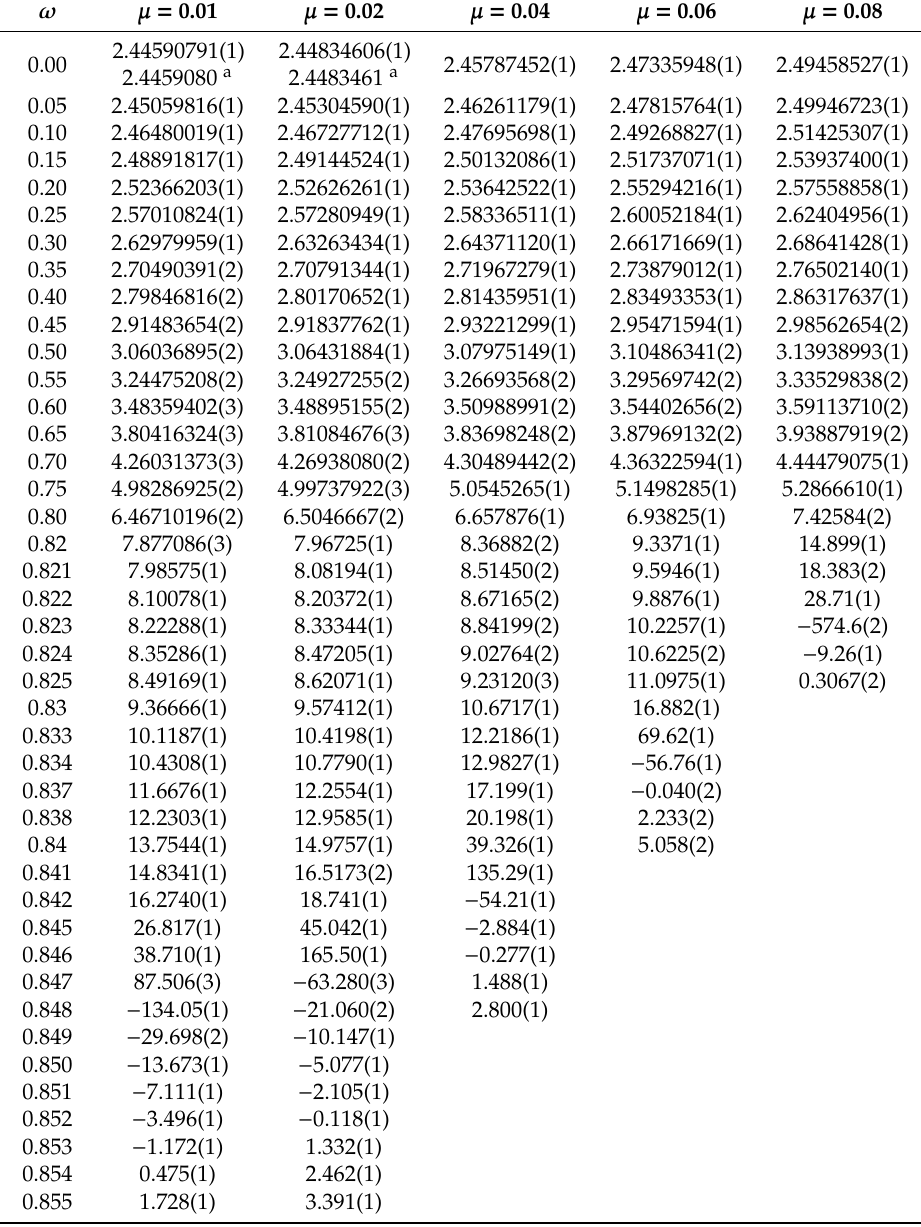
Table 2. The dynamic quadrupole polarizability (in a.u.) of the screened-helium for di ff erent screening parameter and frequency. The numbers in the parentheses denote the uncertainty in the last quoted digits. a Ref. [7].